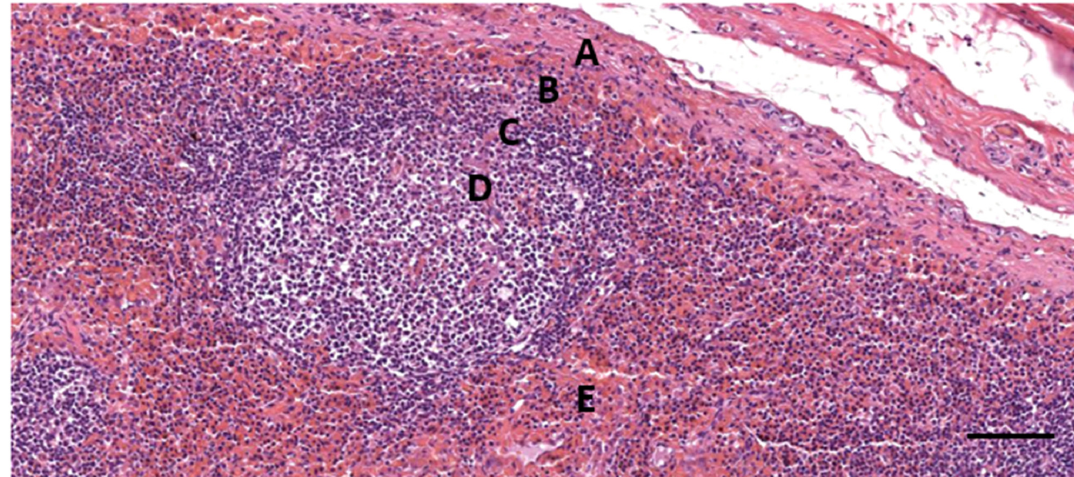
Figure 9. A histological image of Masson’s trichrome staining of a parasagittal section through the region of the left external ear canal of a striped dolphin (ID127565). The bottom image shows the detail of the nodular tissue showing the presence of red blood cells (grey arrowhead), lymphocytes (black arrowhead), and macrophages (white arrowhead). 1: External ear canal; 2: Cartilage of the